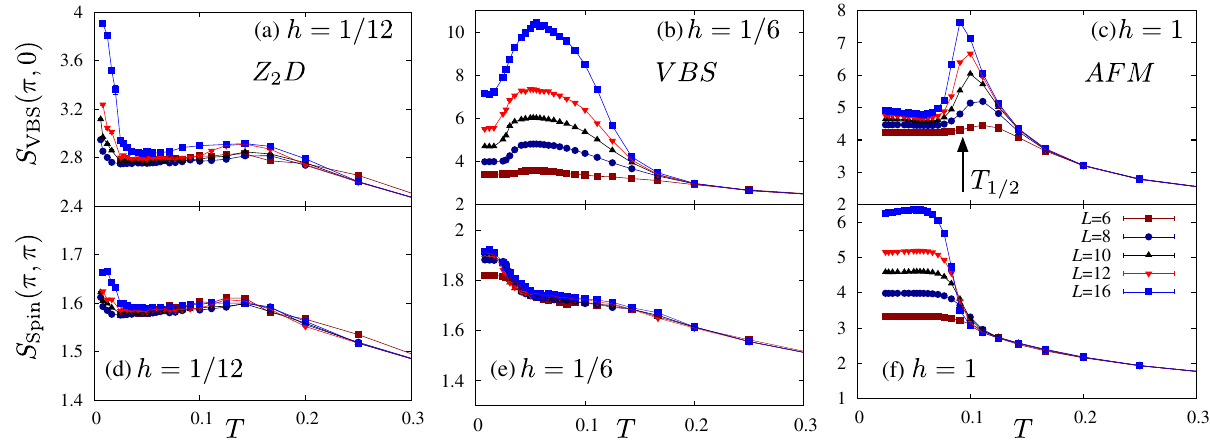
FIG. 18. Temperature dependence of the dimer-dimer and spin-spin correlations in the Z 2 D, VBS and AFM phases of the N ¼ 3 model. The arrow in Fig.(c) corresponds to the energy scale at which h